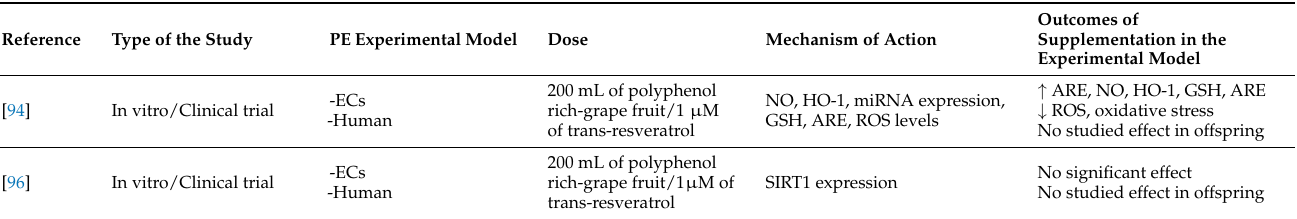
Table 1. Studies using resveratrol in the treatment of models of pre-eclampsia in